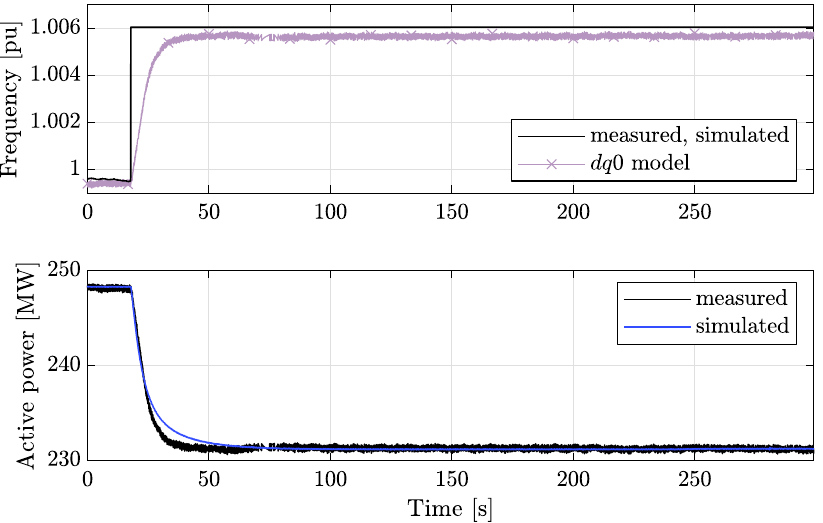
Figure 15. Frequency Control Experiment 2: over-frequency response test. Comparison of simulations and experimental results. The frequency signal is changed from 60 Hz to 60.36